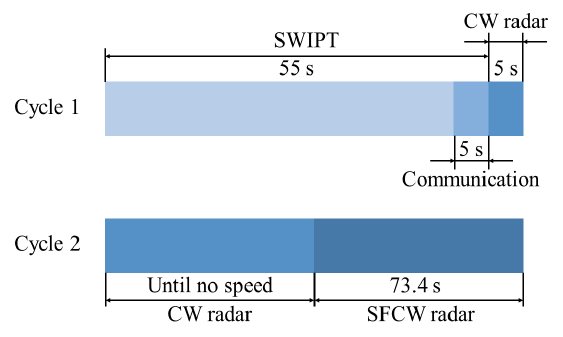
Figure 8. The time allocated for each mode in the two